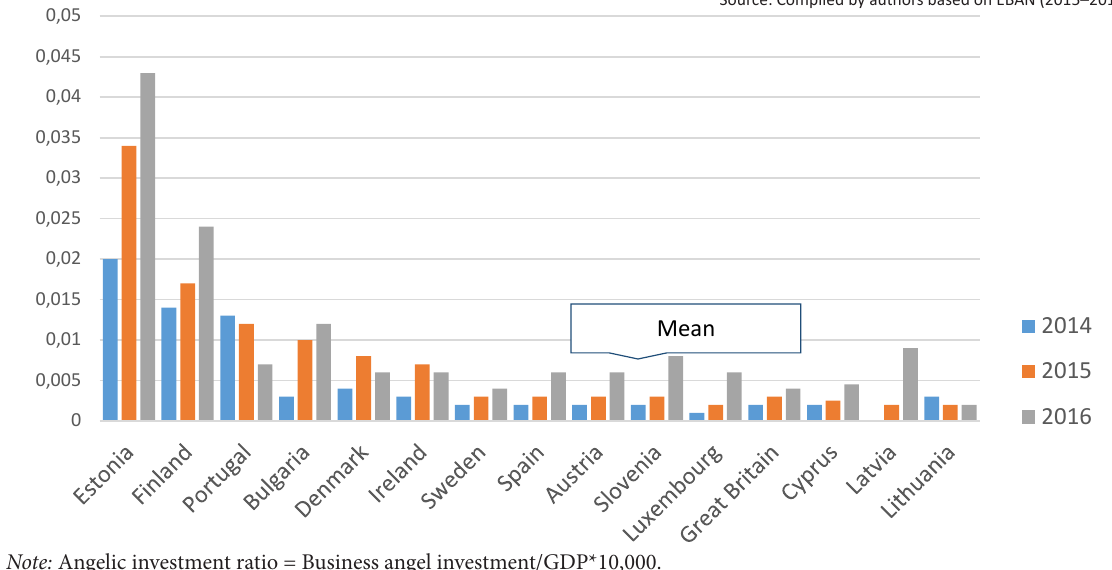
Figure 5. Dynamics of angelic investment ratio in EU countries for 2014–2016